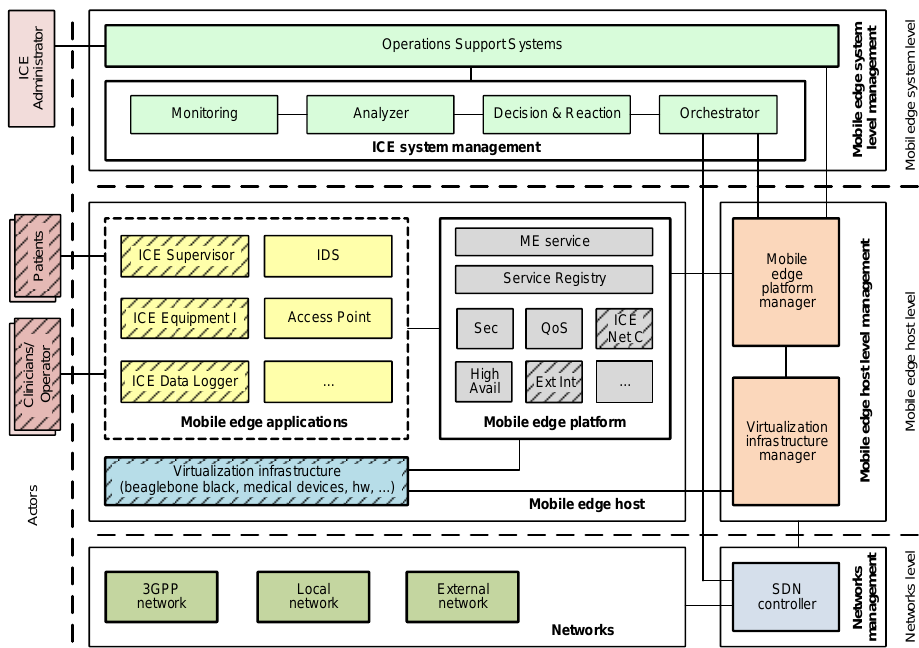
Figure 5. ICE++ architecture oriented to the Mobile Edge Computing (MEC)